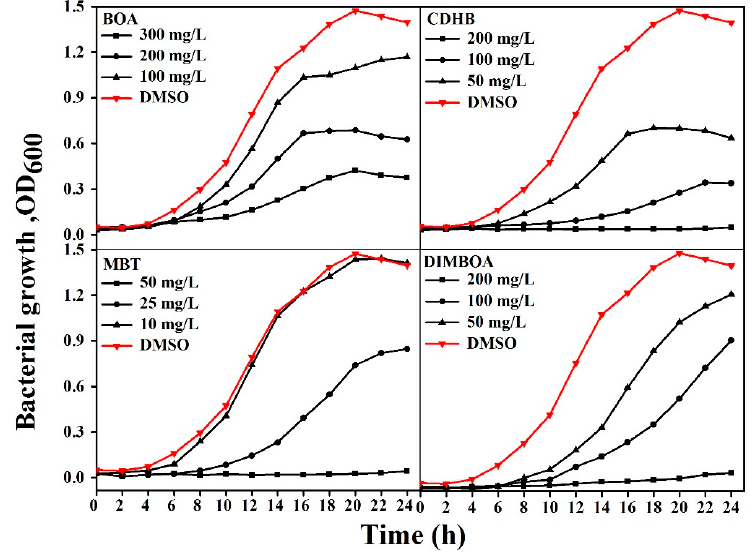
Figure 3. The effect of DIMBOA and its derivatives at different concentrations on the growth curves of R. solanacearum . R. solanacearum